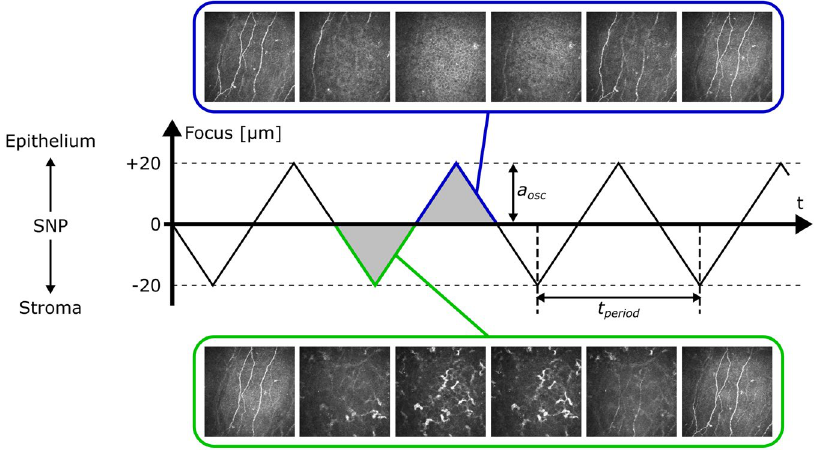
Figure 4. Oscillation of the focus plane during image acquisition. The focus starts in the SNP layer, and then describes a periodic triangular function. E1 E2 E3 E4